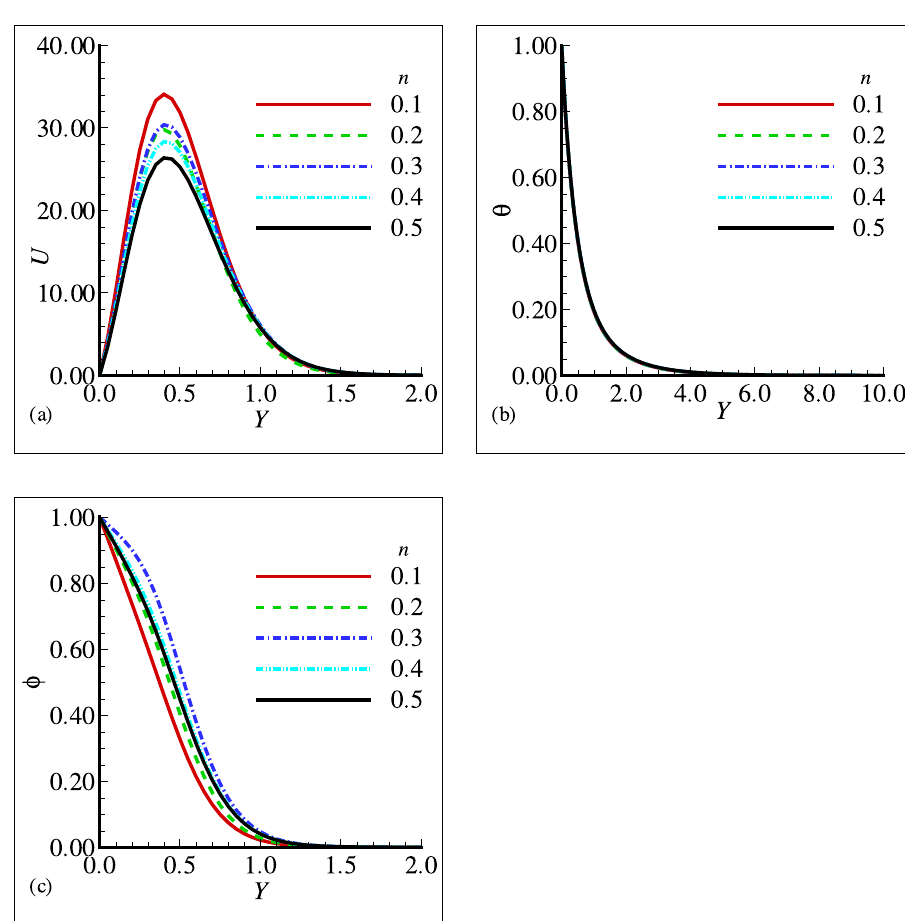
Fig 6. Profiles for (a) U (b) θ and (c) F for different body shape parameter n with Pr = 7.0, Sc = 0.8, E = 0.1, β = 1.0, γ = 0.5, λ = 0.5, ξ = 0.2 and γ μ =